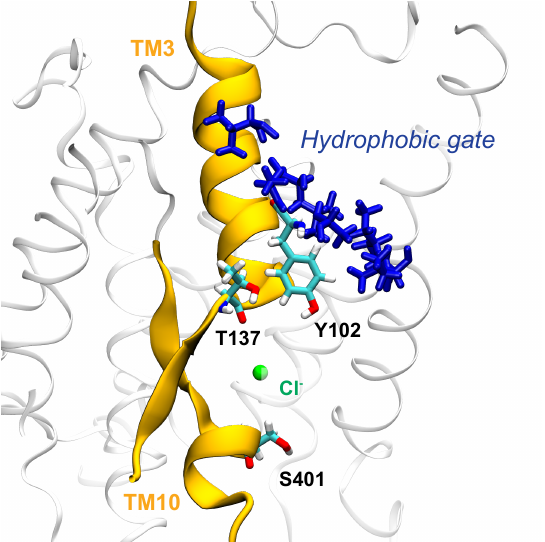
Figure 10. Cl − ion in the binding cavity of zI where it can interact with the hydroxyl groups of Y102 and T137; we suggest that these strong electrostatic interactions can drive the conformational change, by leading to the opening of the hydrophobic cluster (residues A101, A103, L105, V108, I446, I447) located above the binding